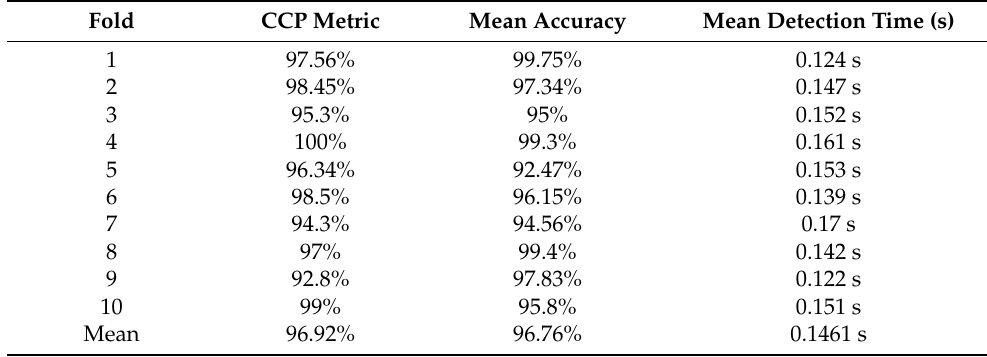
Table 8. Results of the proposed network architecture using a 10 fold cross validation